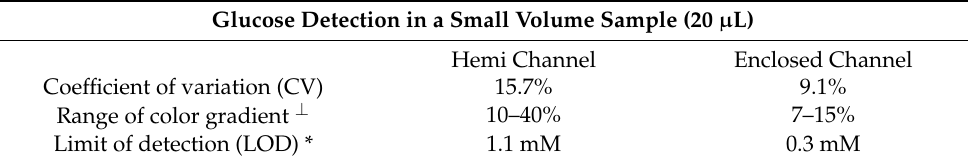
Table 2. Comparison of glucose detection results of hemi channel and enclosed channel. To maximize